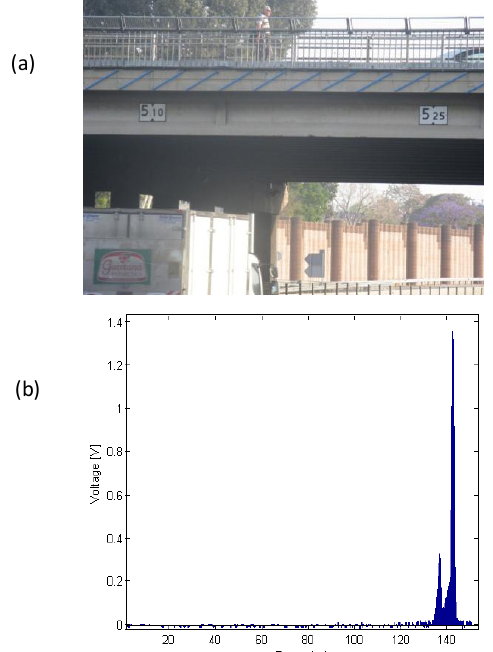
Figure 6. Height limitations for cars driving through the interchange (a), One of the waveforms at the interchange